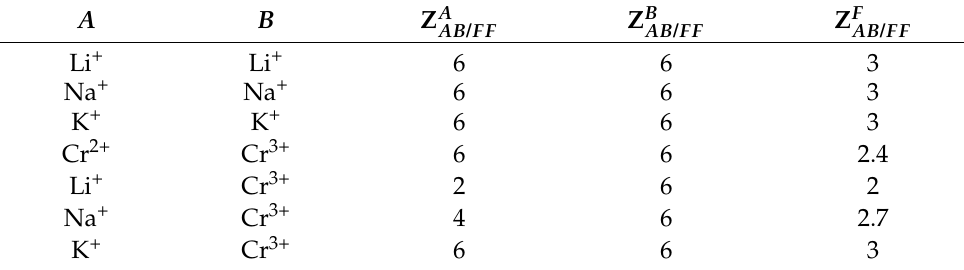
Table 3. Cation–cation coordination numbers of the liquid